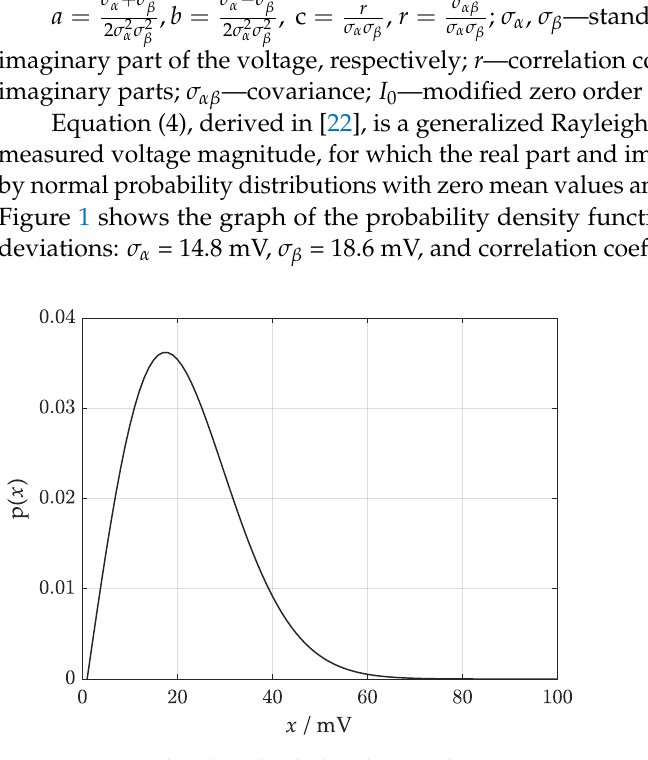
Figure 1. Generalized Rayleigh distribution characterizing measurand. The measured voltage magnitude x is a de-stimulant of quality and too high values speak against the product. The binary classification of product items, distinguishing between correctly made (conforming with specification) items and items that exceed the specified voltage magnitude level (non-conforming), is performed by direct comparison with the upper acceptance limit D u using an analog comparator, for which we know the standard uncertainty of the threshold. Distribution of the comparator threshold depends on stochastic and deterministic effects. It represents stochastic temporal noise comprising thermal and flicker noise, and the deterministic offset due to fabrication imperfection and transistor mismatch. It was found empirically that the distribution of the comparator threshold is Gaussian